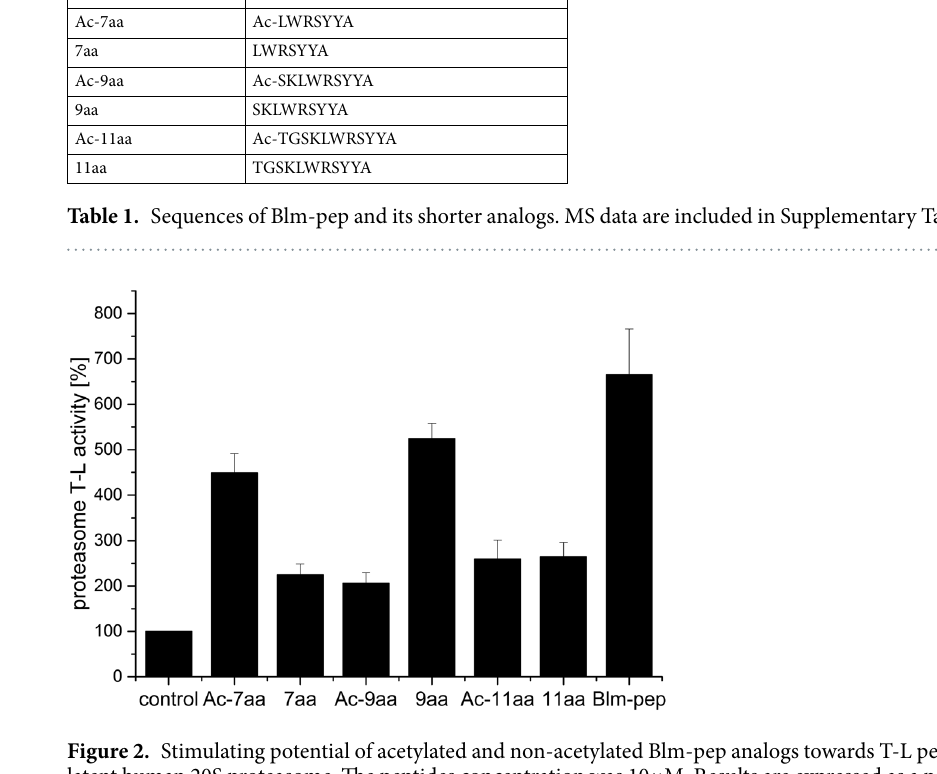
Figure 2. Stimulating potential of acetylated and non-acetylated Blm-pep analogs towards T-L peptidase of the latent human 20S proteasome. The peptides concentration was 10 μ M. Results are expressed as a percentage of activity of the latent human 20S proteasome. The variability of the data is presented as standard deviation error